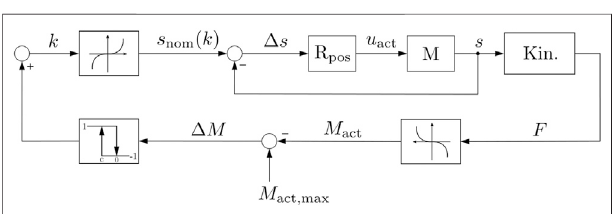
FIGURE 10 | Control loop of the exoskeleton. The controller follows a prede fi ned position signal in the inner control loop and is limited by a torque- based two-point